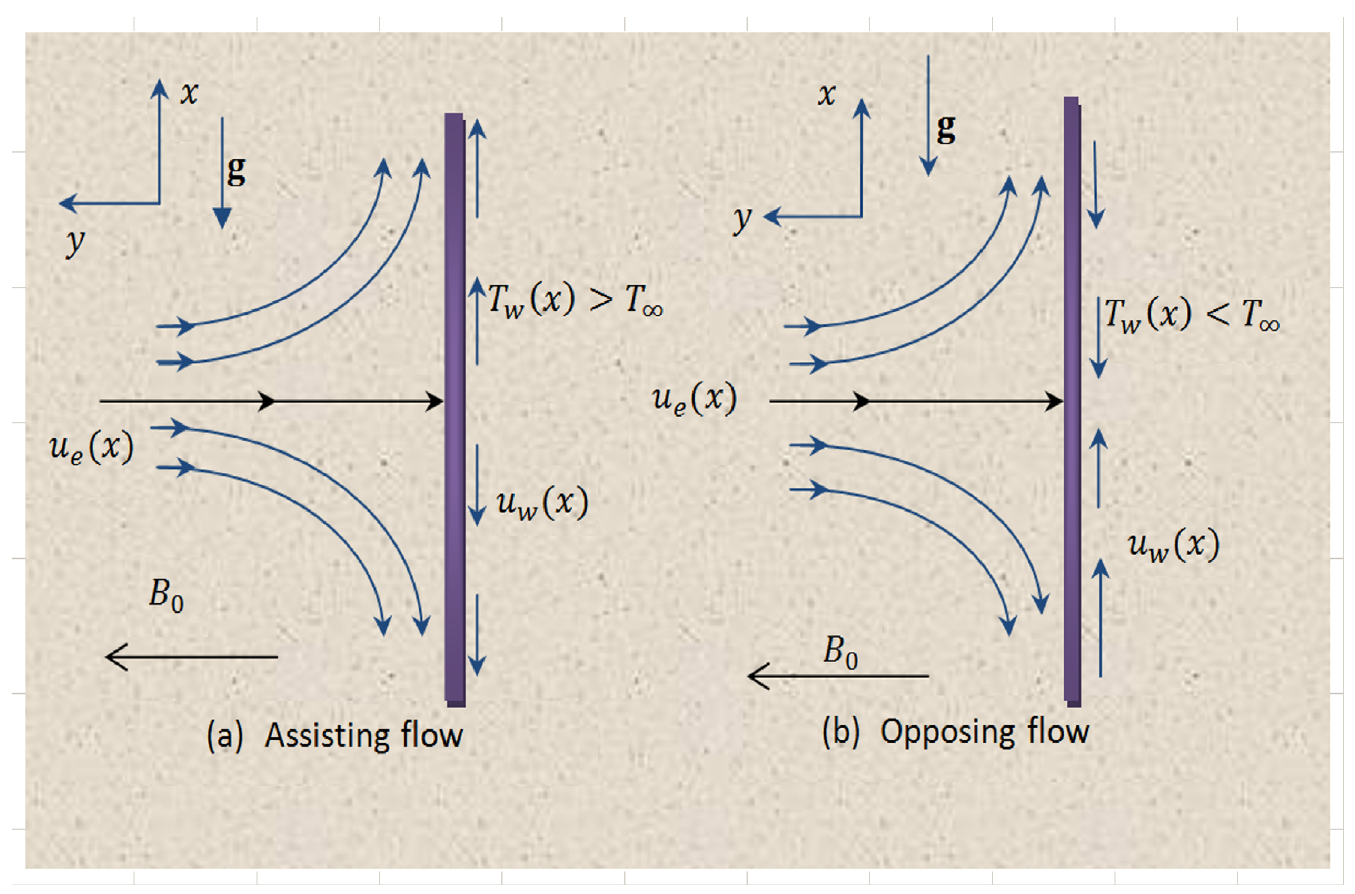
Fig 1. Physical model and coordinate